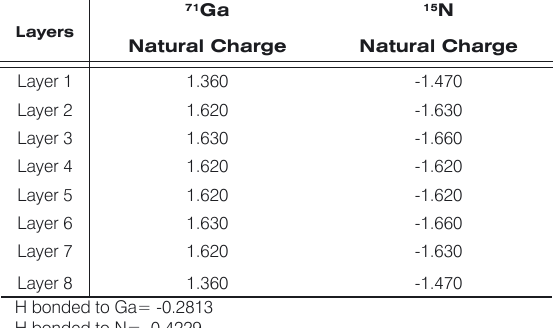
Table 5. The 71 Ga and 15 N Natural Charges in the (4, 4) GaNNT.